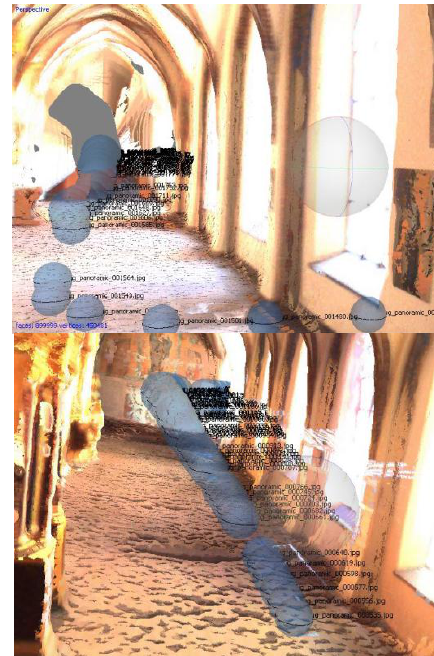
Figure 15. A view inside the 3d reconstructed cloisters where the position of panoramas is